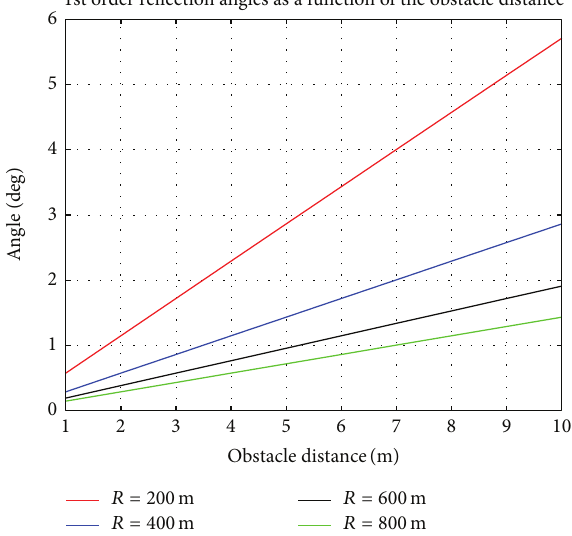
Figure 4: First order reflection angles 𝛼 as a function of the obstacle distance ( a ).